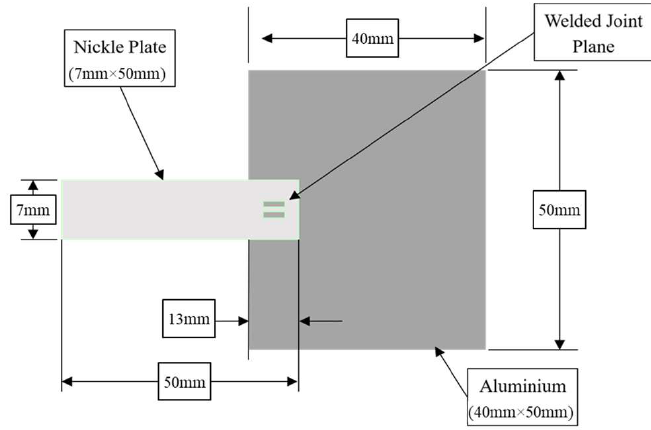
Figure 1. Test specimen size.